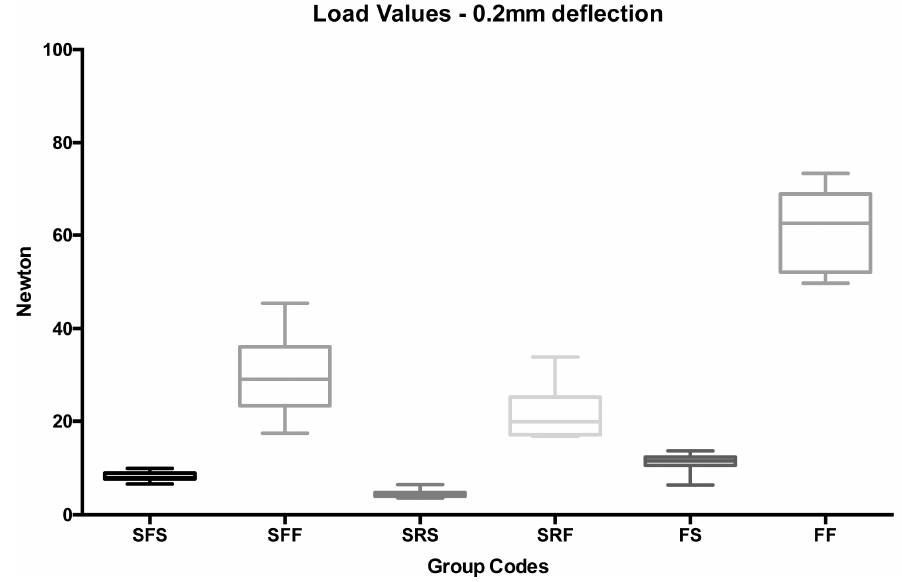
Figure 2. Box plot of load values (N) of the various groups tested at 0.2 mm deflection.